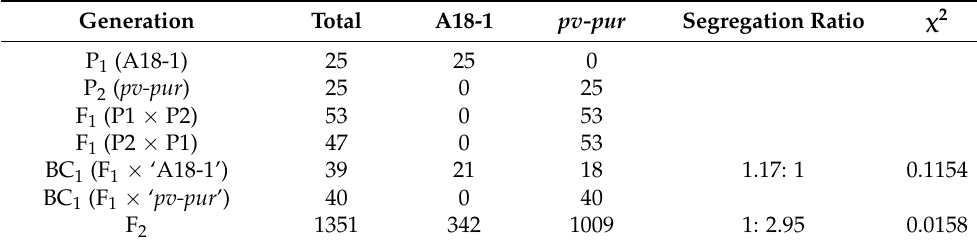
Table 1. Genetic analysis of purple mutant pv-pur in Phaseolus vulgaris.